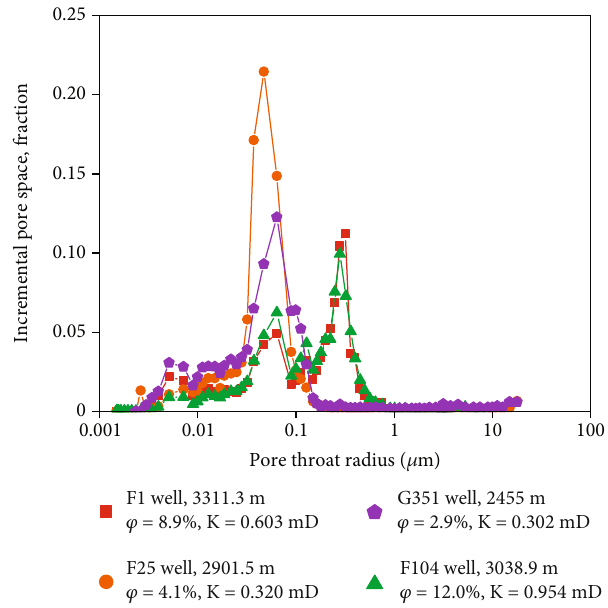
Figure 9: Typical pore throat radius distribution obtained from the HPMI